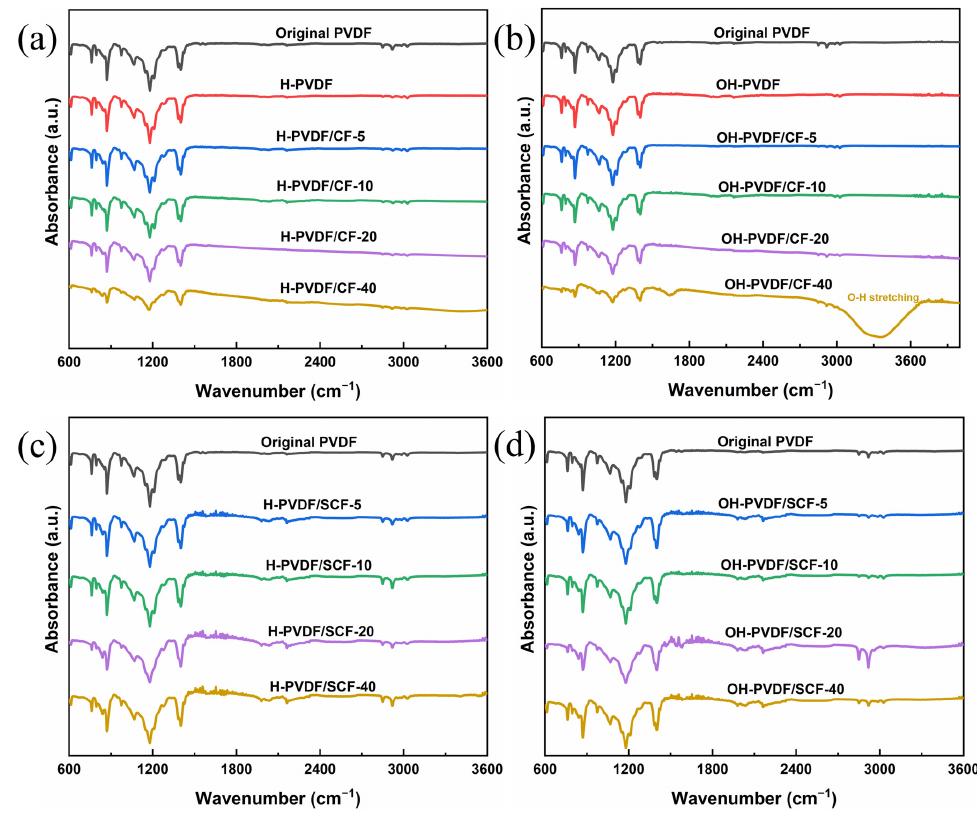
Figure 11. FTIR spectra of the pure PVDF and the PVDF/CF composites in ( a ) acid and ( b ) alkaline environments; and the PVDF/SCF composites in ( c ) acid and ( d ) alkaline environments.